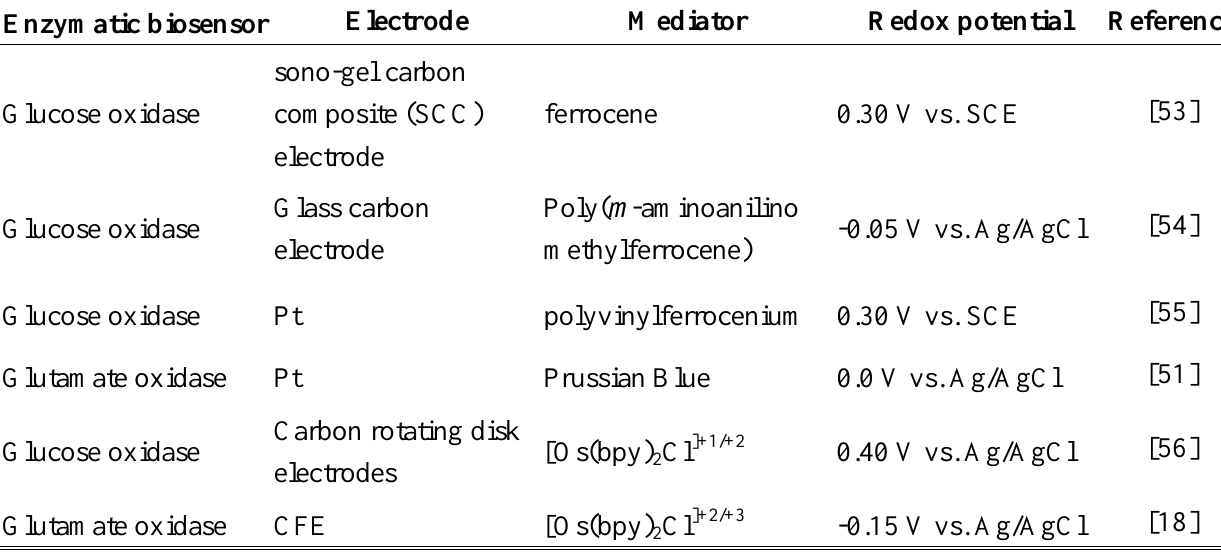
Table 3. Enzymatic biosensors with different redox mediators and their application